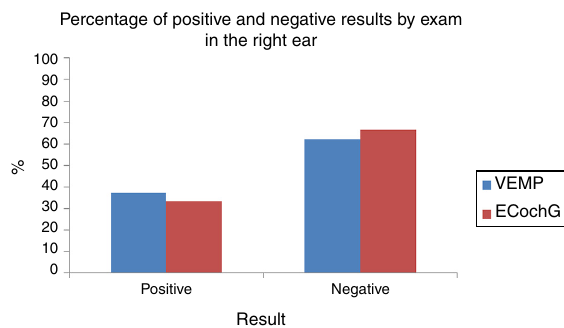
Figure 5 Percentage of positive and negative results by exam in the right ear.